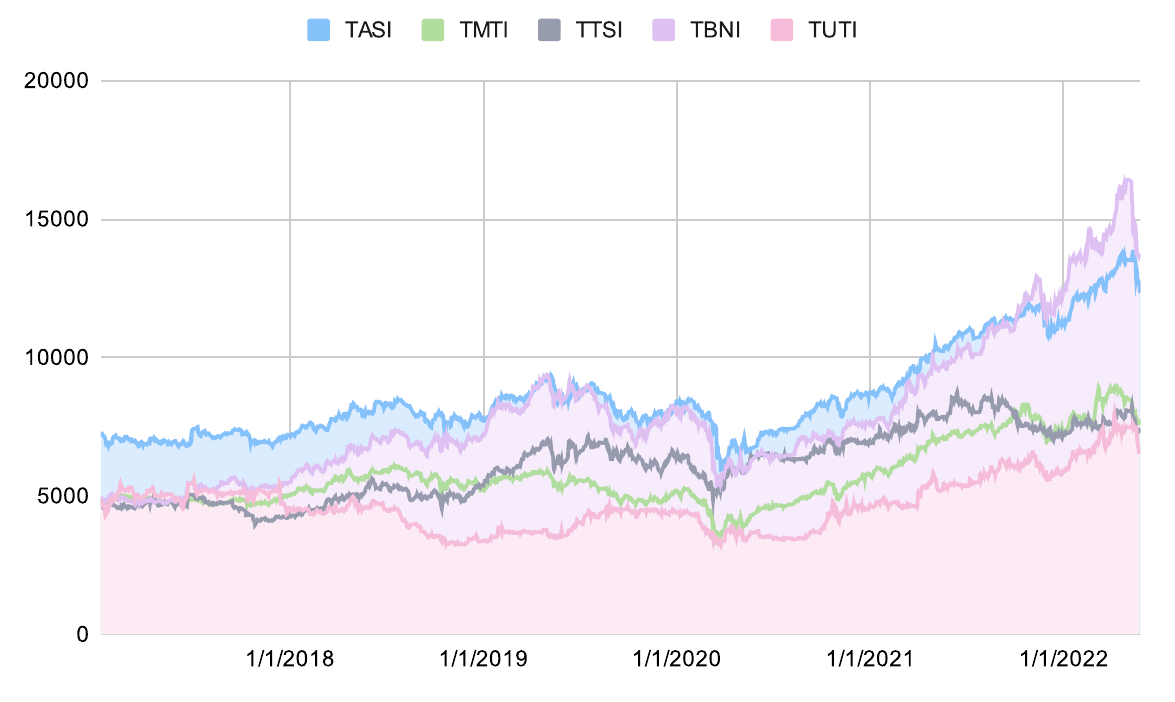
Figure 4. Comparison of performance of the four selected indices with that of the Tadawul All Share Index (TASI).